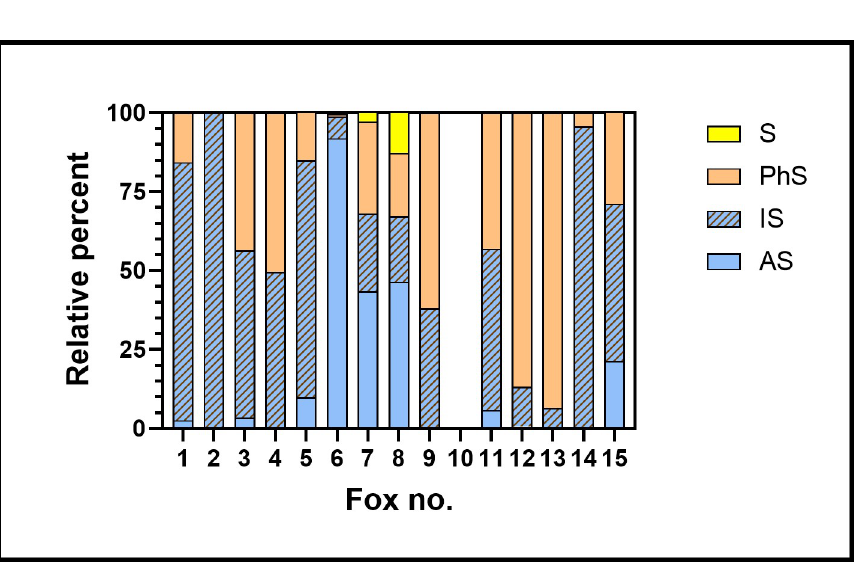
Fig 5. Sulfur compounds found in the urine of 15 foxes. Amounts are expressed as the percentage of all sulfur compounds in each fox, then grouped as in Table 1: alkyl (AS), isoprenoid (IS), phenyl (PhS) and elemental sulfur (S). Foxes 12 and 13 were female, and fox 10 produced no detectable sulfur